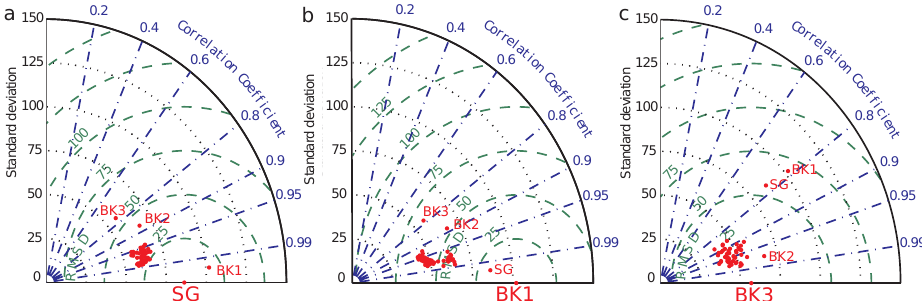
Fig. 7. Taylor diagrams (Taylor, 2001) comparing measured and modelled WSC for the models SG (a), BK1 (b) and BK3 (c). Each figure also contains the measured WSC for the other